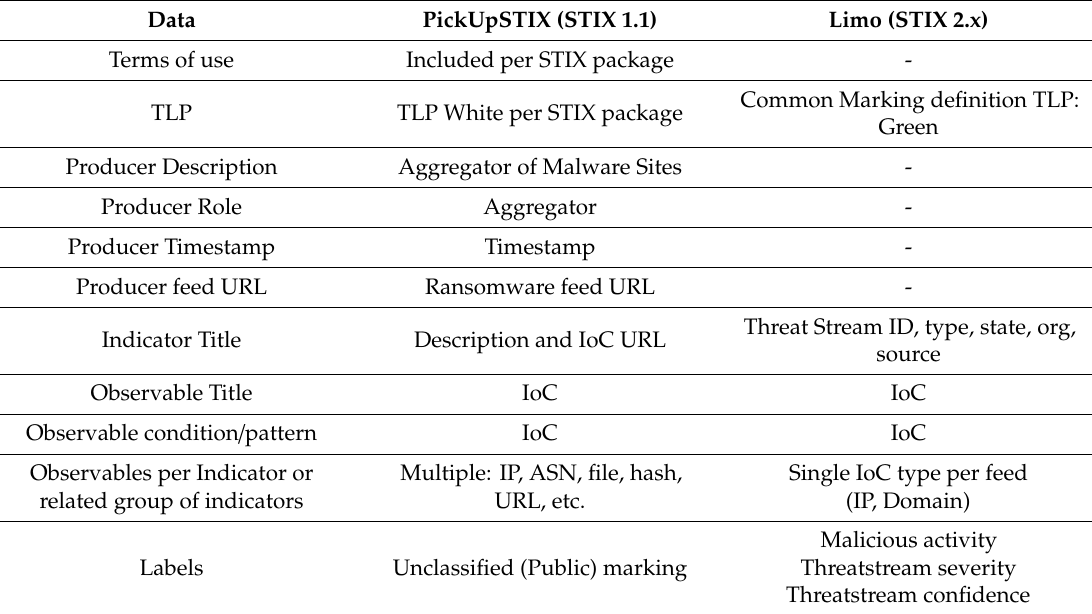
Table 4. STIX, PickUpSTIX and Limo metadata comparison.